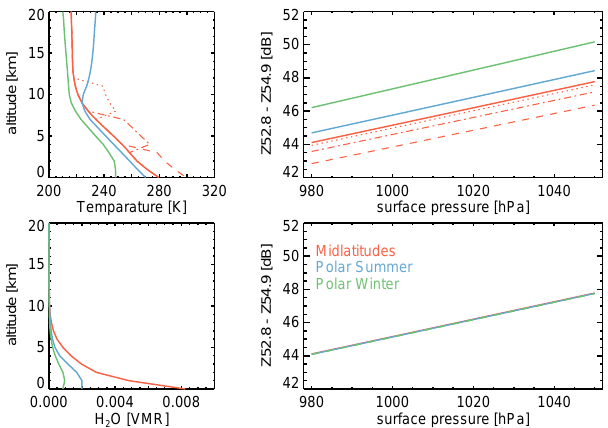
Figure 3. Simulated clear-sky relationships between surface pres- sure and surface radar returns. The top row shows the effect of varying the temperature profile while the bottom shows the effect of varying water vapor. Each color-coded point represents an ad- justment of the entire pressure